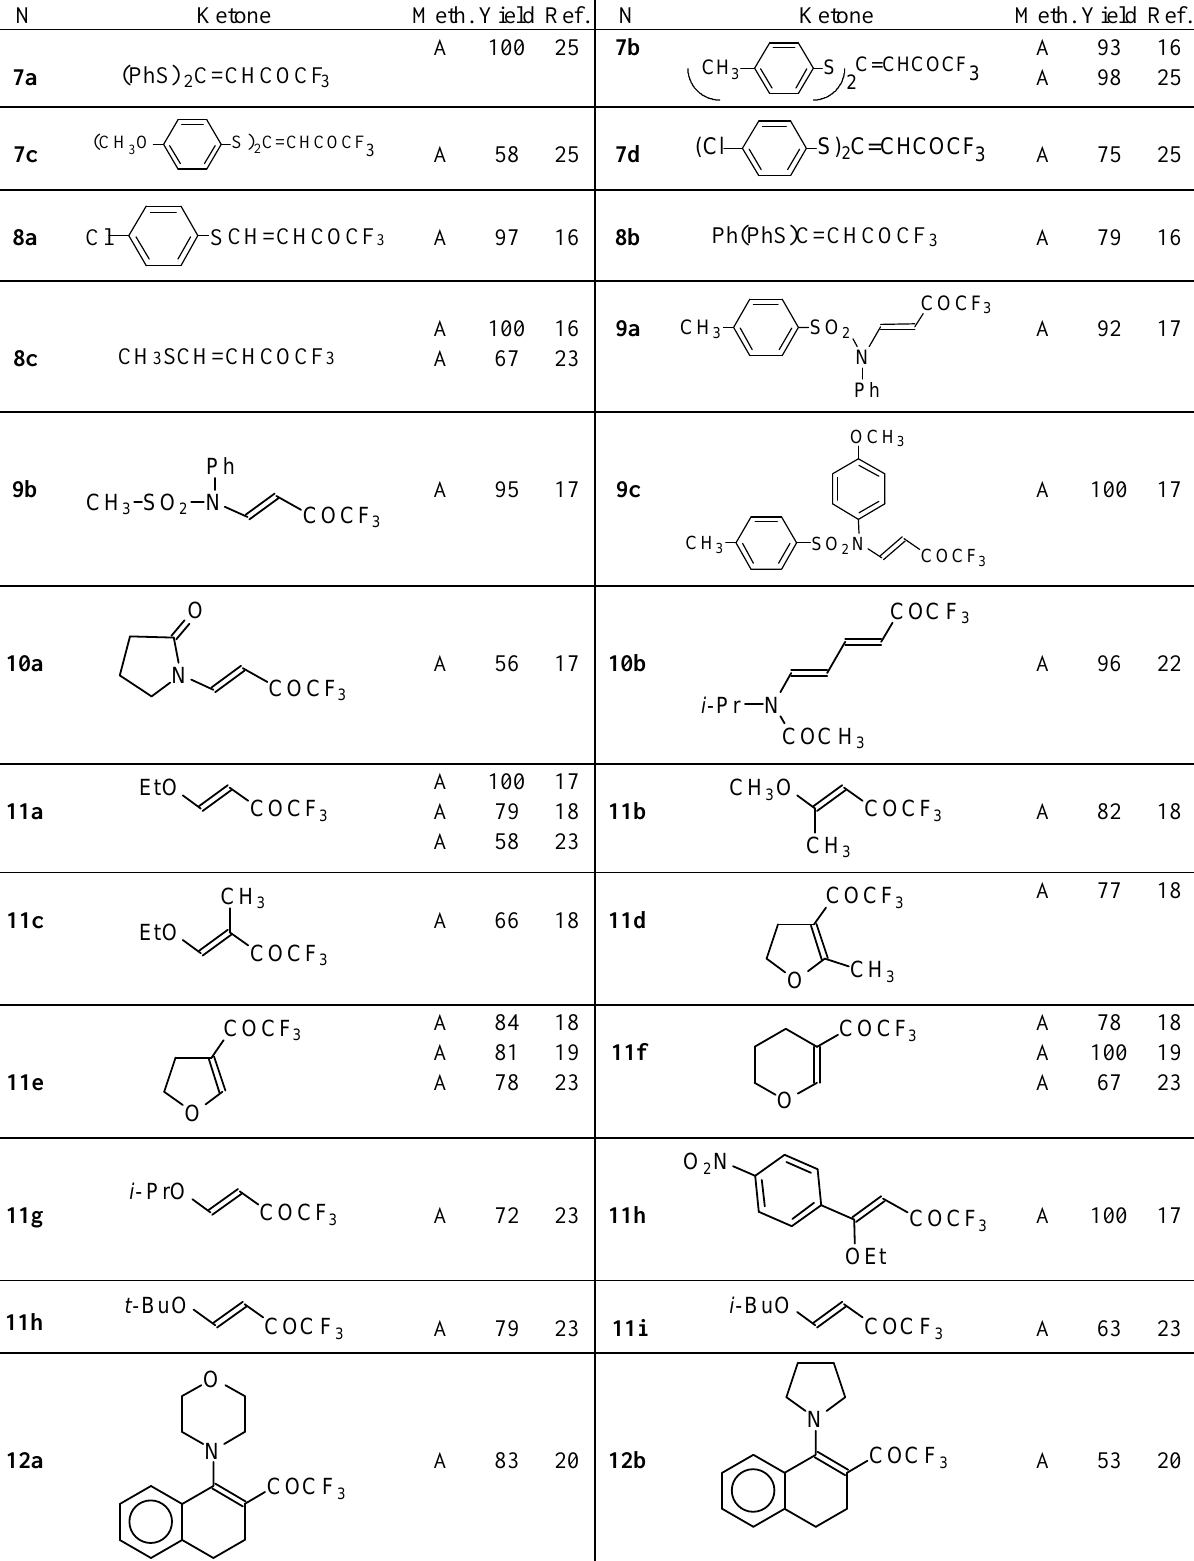
Table 1. Synthesis of a , b - unsaturated trifluoromethyl ketones. N Ketone Meth. Yield Ref. N Ketone Meth. Yield